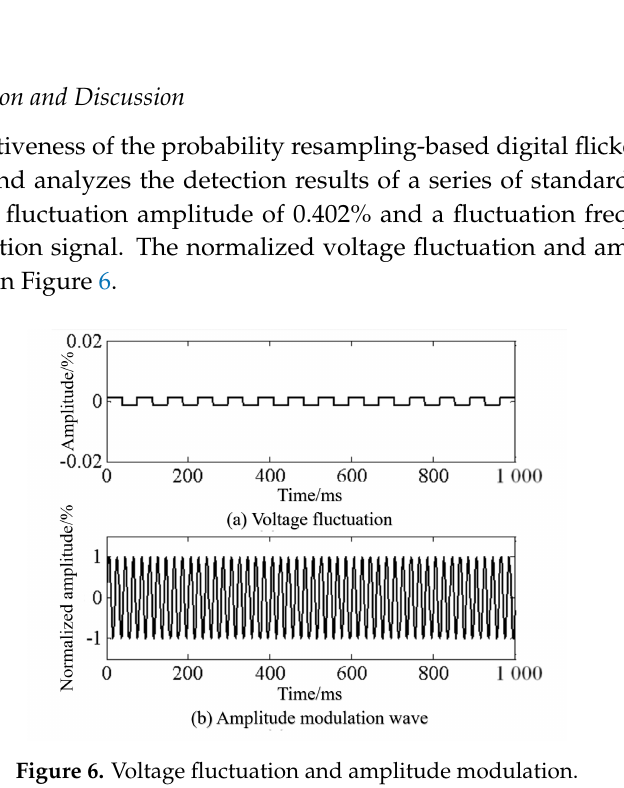
Figure 6. Voltage fluctuation and amplitude